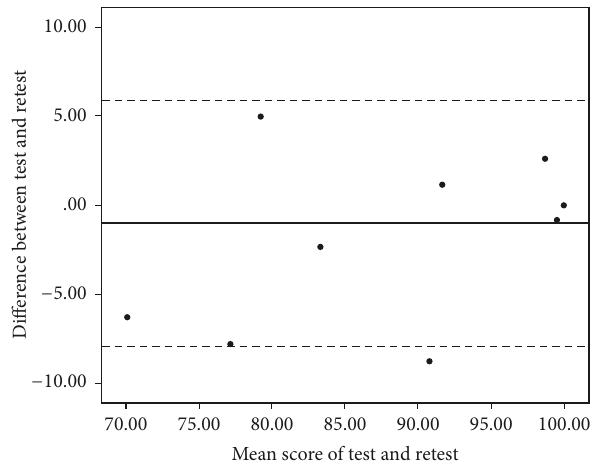
Figure3:Bland-Altmanplotofthetest-retestreliabilityoftheDutch TESS-UE. The solid line shows the mean difference of the two tests ( − 1.01)andthedashedlinesshowthe95%limitsofagreement( − 7.89; 5.86). The dot with 0 difference between test and retest and a 100 mean score represents ten